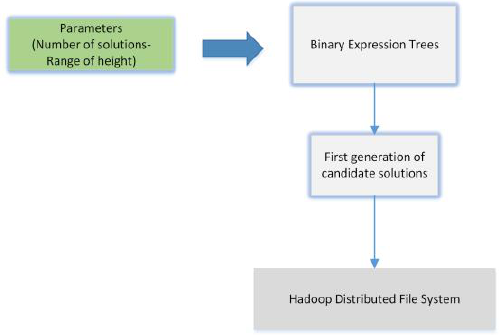
Figure 3. Data flow for data preparation subsystem.